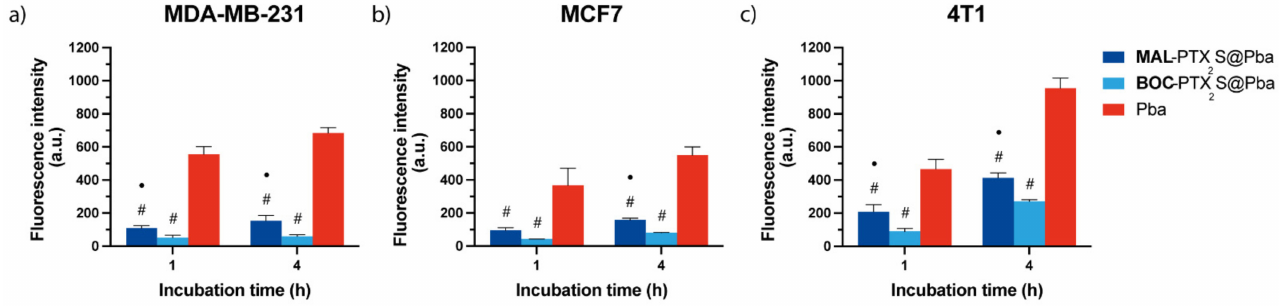
Figure 5. In vitro uptake of the different Pba formulations in MDA-MB-231 ( a ), MCF7 ( b ) and 4T1 ( c ) cells cultured as monolayers. Cells were incubated for 1 or 4h with 0.25 µ M of Pba dissolved in the standard solvent or loaded in MAL -PTX 2 S@Pba or in BOC -PTX 2 S@Pba, and the uptake of Pba was measured by flow cytometry at the end of incubation times. Data are expressed as mean percentage ± SD of least three independent experiments, carried out in triplicate. Statistical